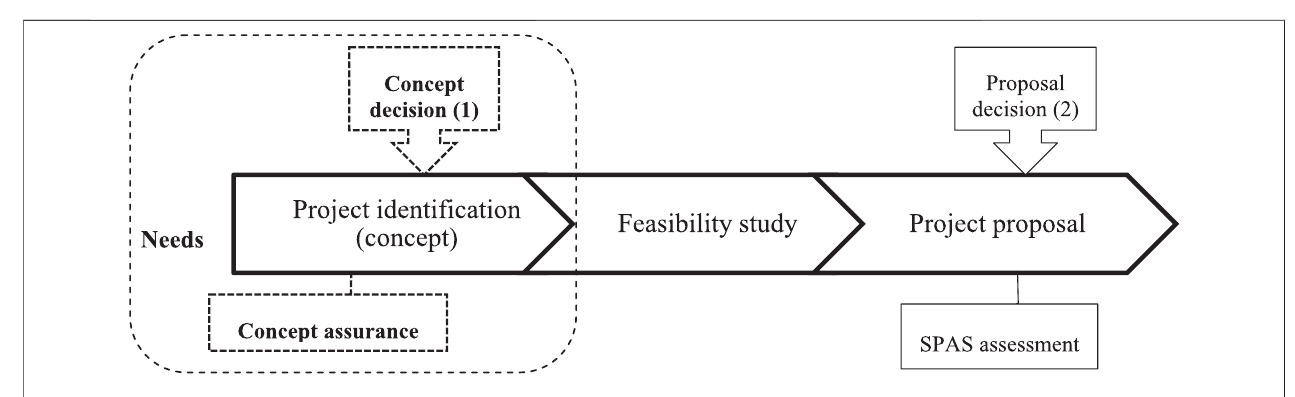
FIGURE 7 | Model of concept